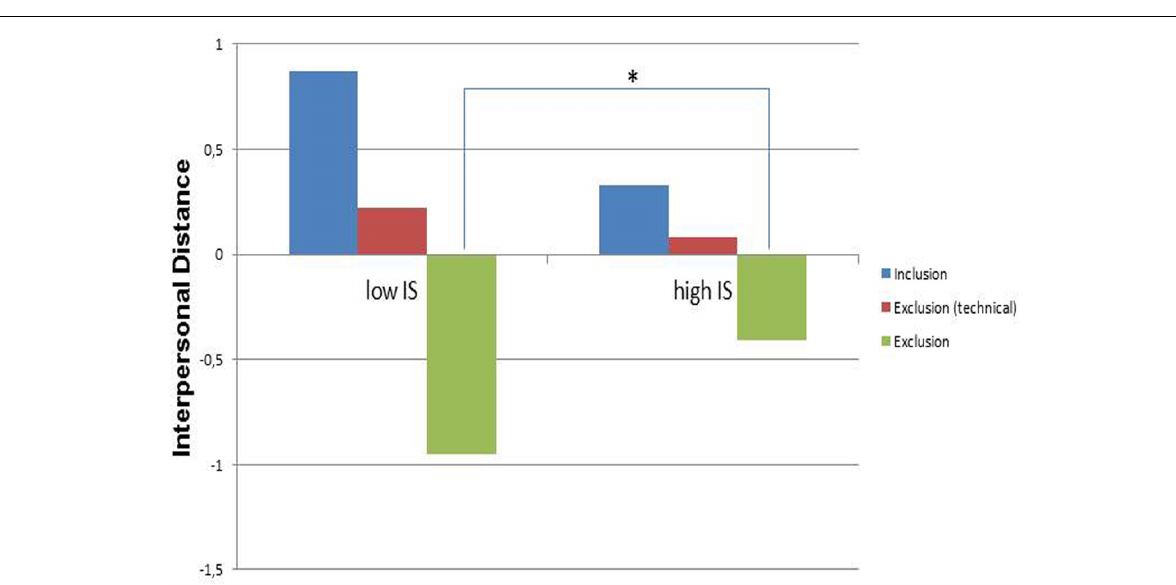
behavioral affiliation tendencies following social exclusion.